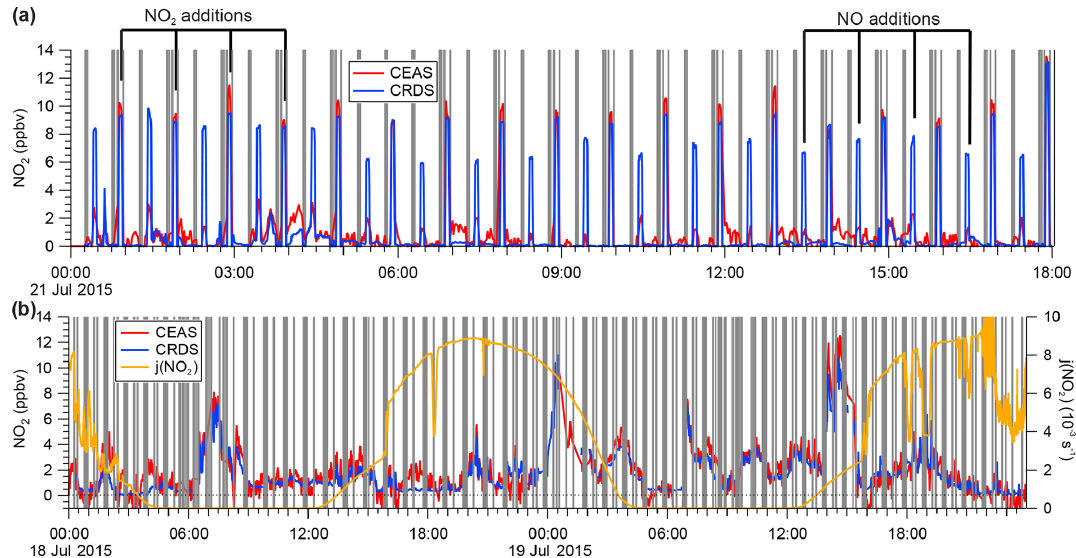
Figure 6. (a) Sample time series of continuous IBBCEAS and CRDS data collected during the ORCA campaign showing measurements of ambient air, NO 2 -free zero air (every 30min), and hourly standard additions of NO 2 ( ∼ 10ppbv) in zero air and NO ( ∼ 130ppbv) to ambient air. The areas shaded in grey indicate times when both instruments sampled zero air. When high concentrations of NO were added, more NO 2 was observed by CRDS due to this instrument’s longer inlet residence time. (b) Sample time series of ambient air NO 2 mixing ratios observed by IBBCEAS and CRDS during ORCA.